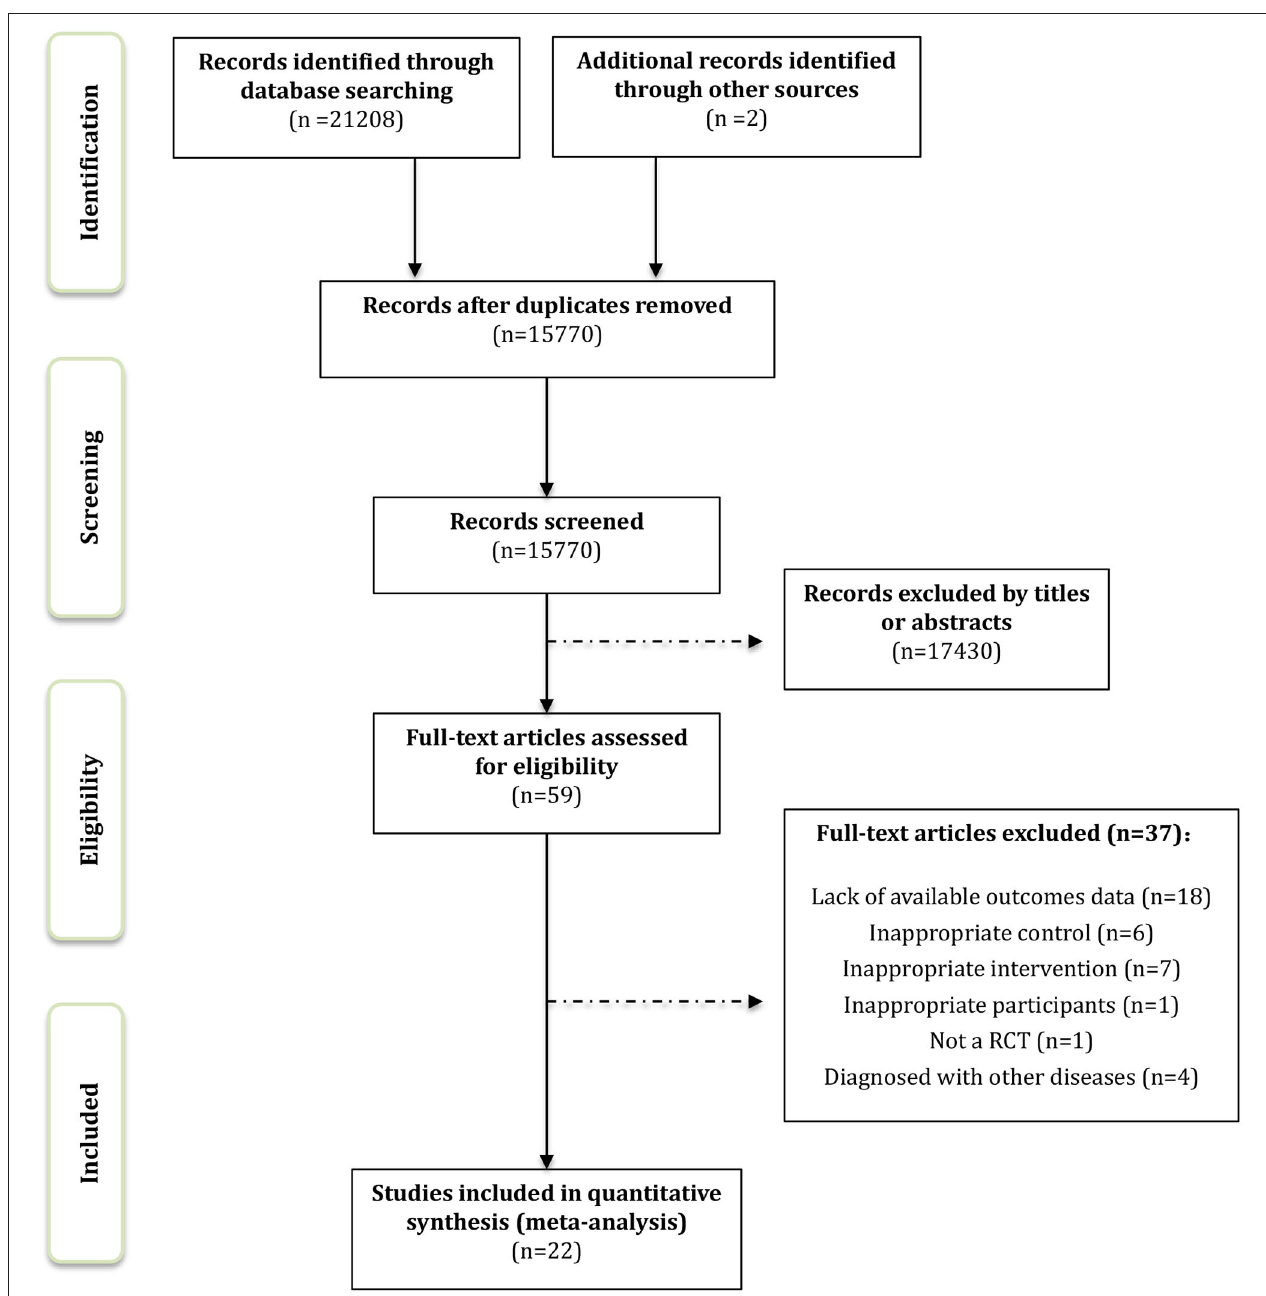
FIGURE 1 | Flowchart representing the selection